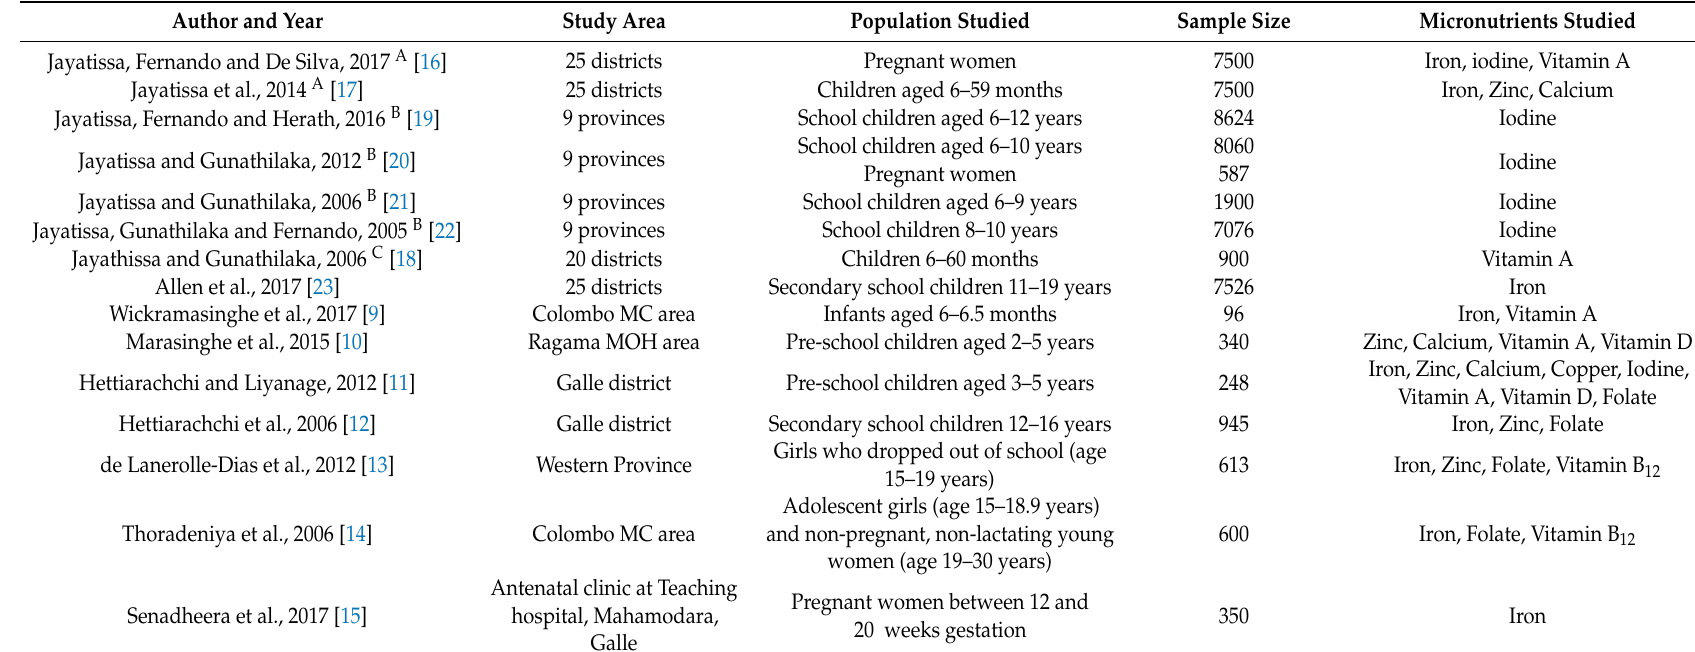
Table 2. Characteristics of the studies included in this